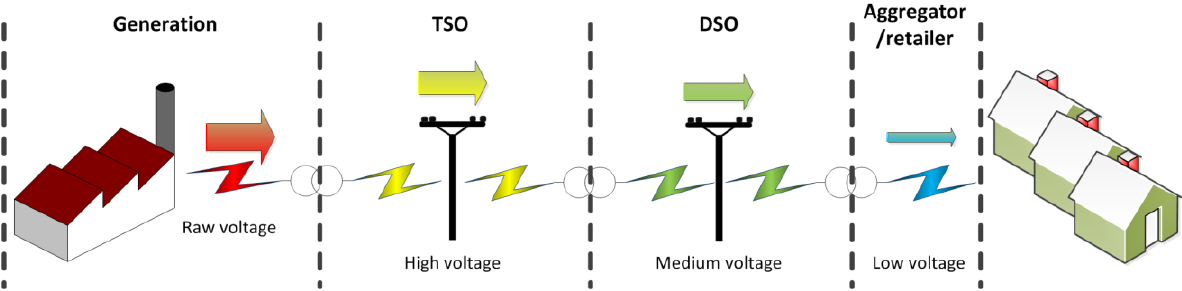
Figure 1. Regular electricity production, distribution and consumption value chain. TSO: transmission system operator; DSO: distributed system operator.